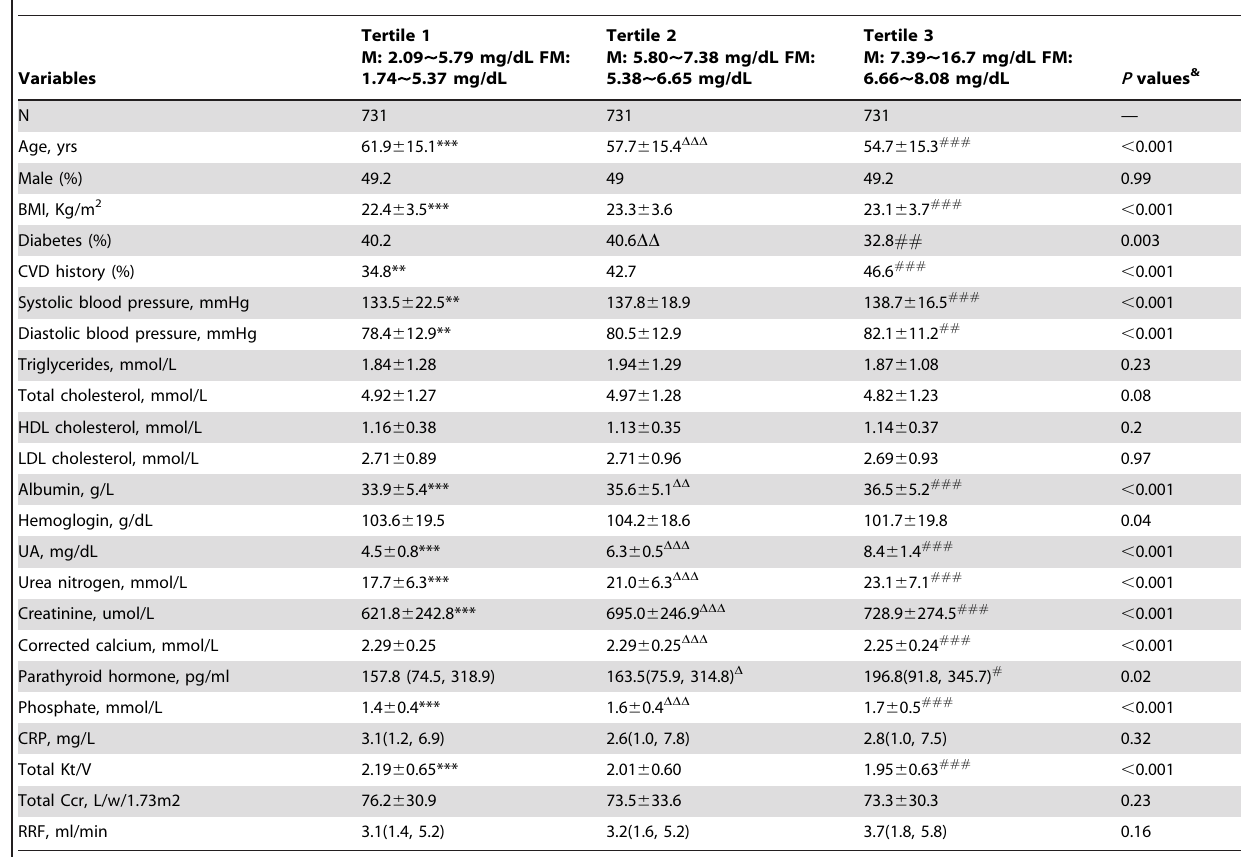
Table 1. Clinical characteristics and biochemistry data of patients by gender-specific tertiles of UA.